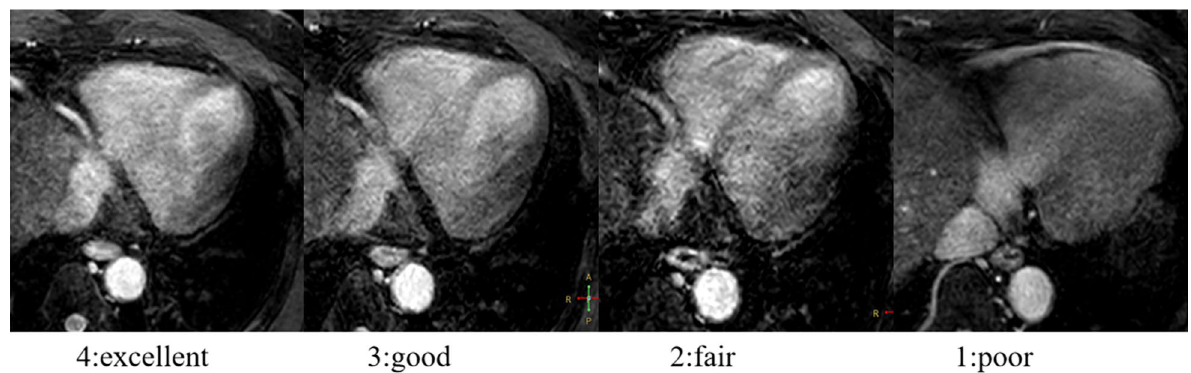
Fig. 4 Four-point subjective score for the qualitative image